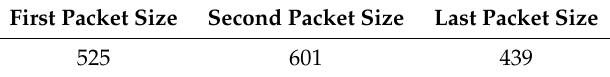
Table 4. Packet size